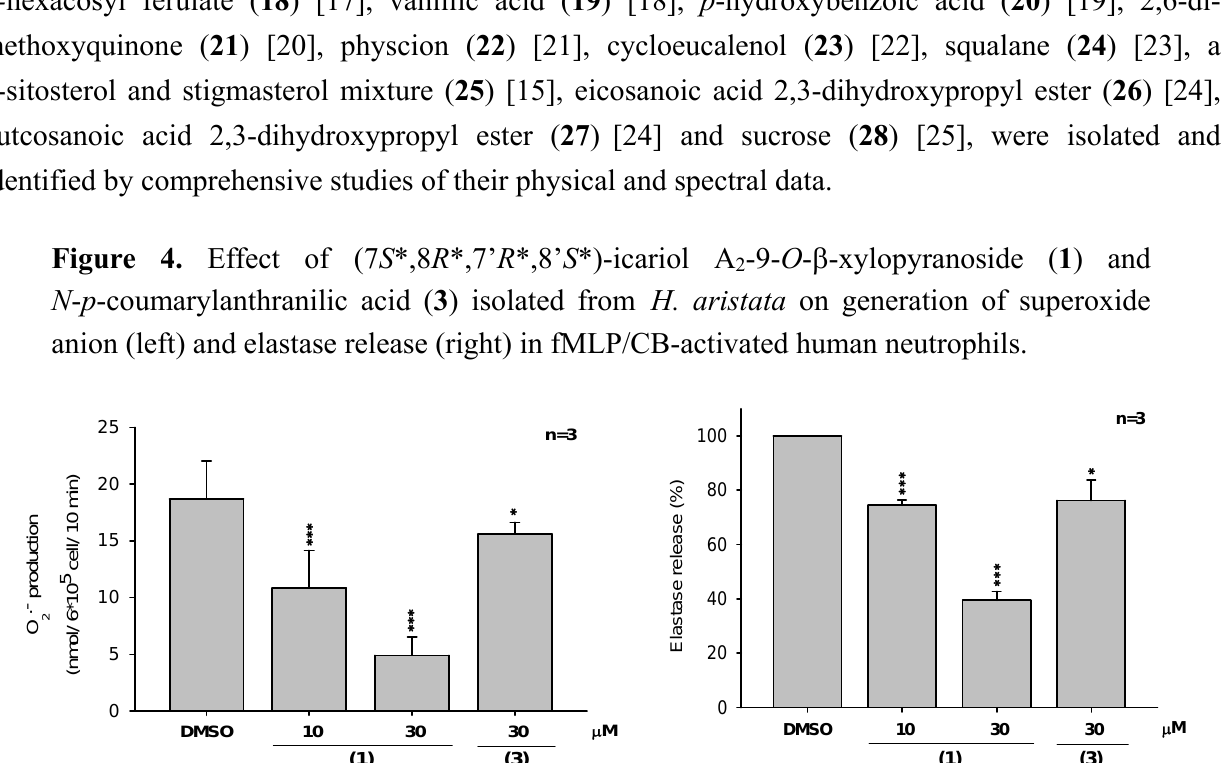
-9- O - β -xylopyranoside ( 1 ) and 2